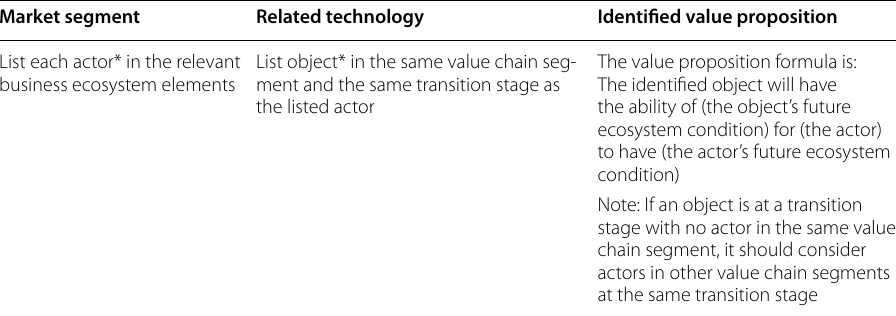
Actor/object is from the column of Relevant business ecosystem elements in Table 14 The future ecosystem description